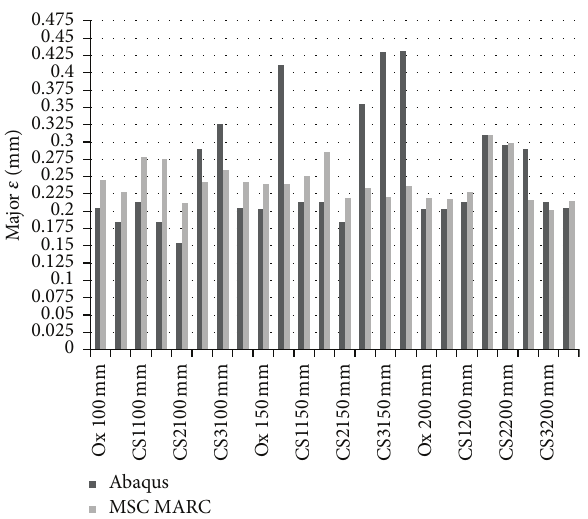
Figure 29: Major deformation for the Nakajima tests: comparison between MSC-MARC and Abaqus.